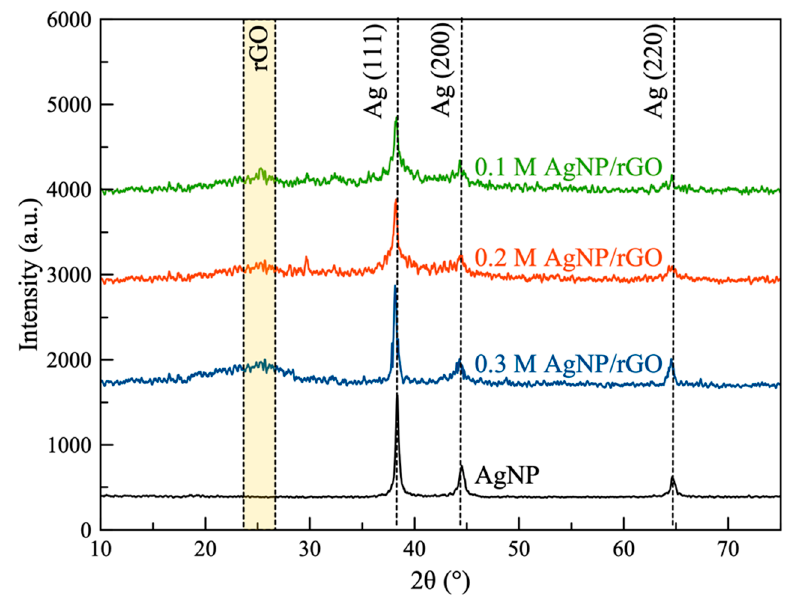
Figure 2. XRD pattern of the synthesized samples: 0.1 M silver nanoparticles (AgNP)/reduced graphene oxide (rGO), 0.2 M AgNP/rGO and 0.3 M AgNP/rGO and silver nanoparticles (AgNP).